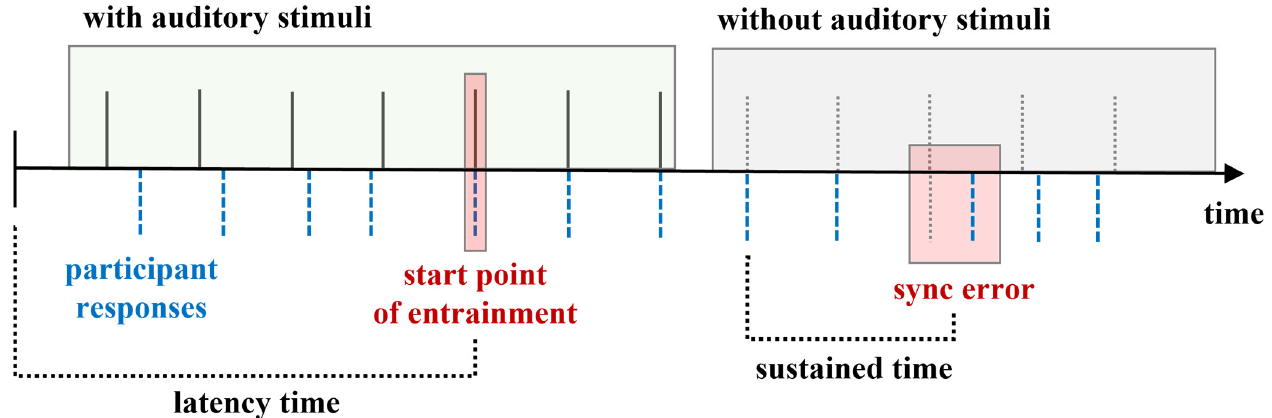
Figure 2. The measurement paradigm of the MIDI drum tapping task. The latency time until the entrainment refers to time from cueing until each participant’s tapping interval started synchronizing. The sustained time of entrainment refers to time until each participant’s tapping became regular without rhythmic cueing.